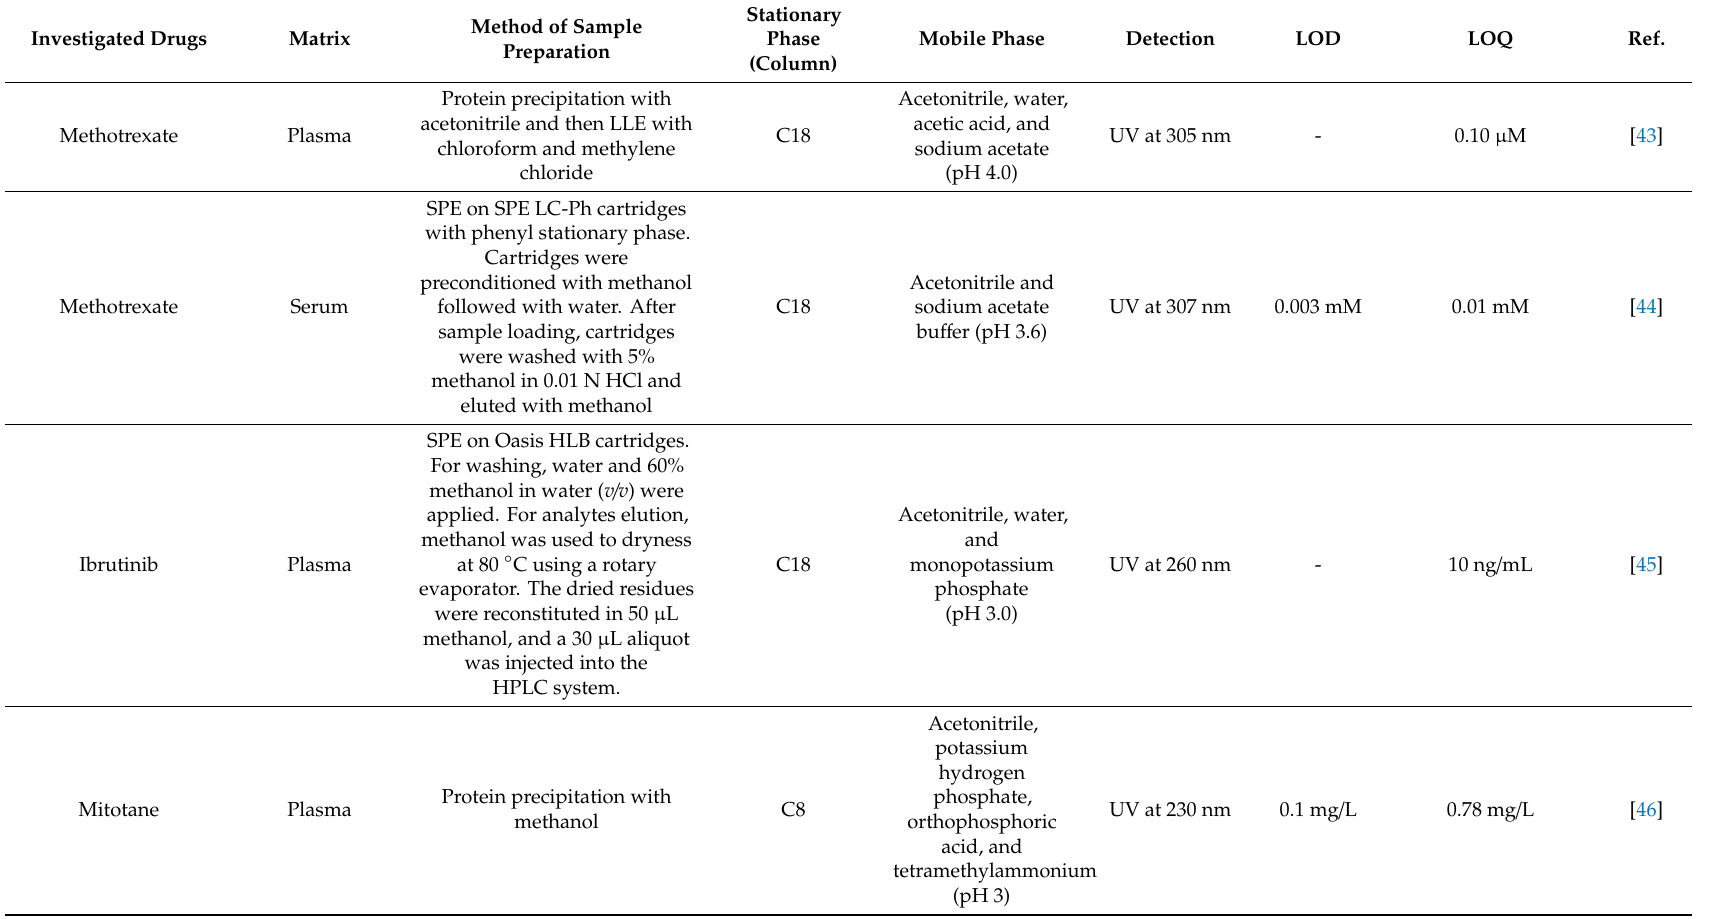
Table 2. Anticancer drugs. LLE: liquid–liquid extraction, SPE: solid-phase